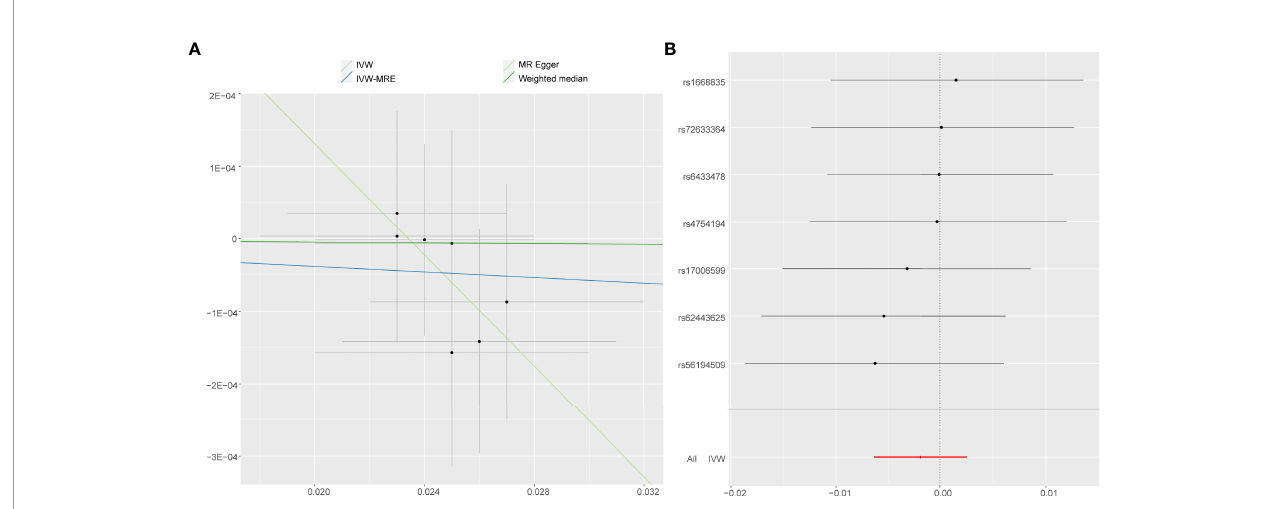
FIGURE 4 | Forest plot and scatter plot of the association of accelerometer-based PA (acceleration fraction >425 mg) with the risk of AS. (A) Scatter plot: each black dot indicates a SNP, plotted by the estimate of SNP on accelerometer-based PA (acceleration fraction >425 mg) and the estimate of SNP on the risk of AS with standard error bars. The slopes of the lines correspond to causal estimates using each of the different methods. (B) Forest plot: the dot and bar indicate the causal estimate of accelerometer-based PA (acceleration fraction >425 mg) on risk of AS.